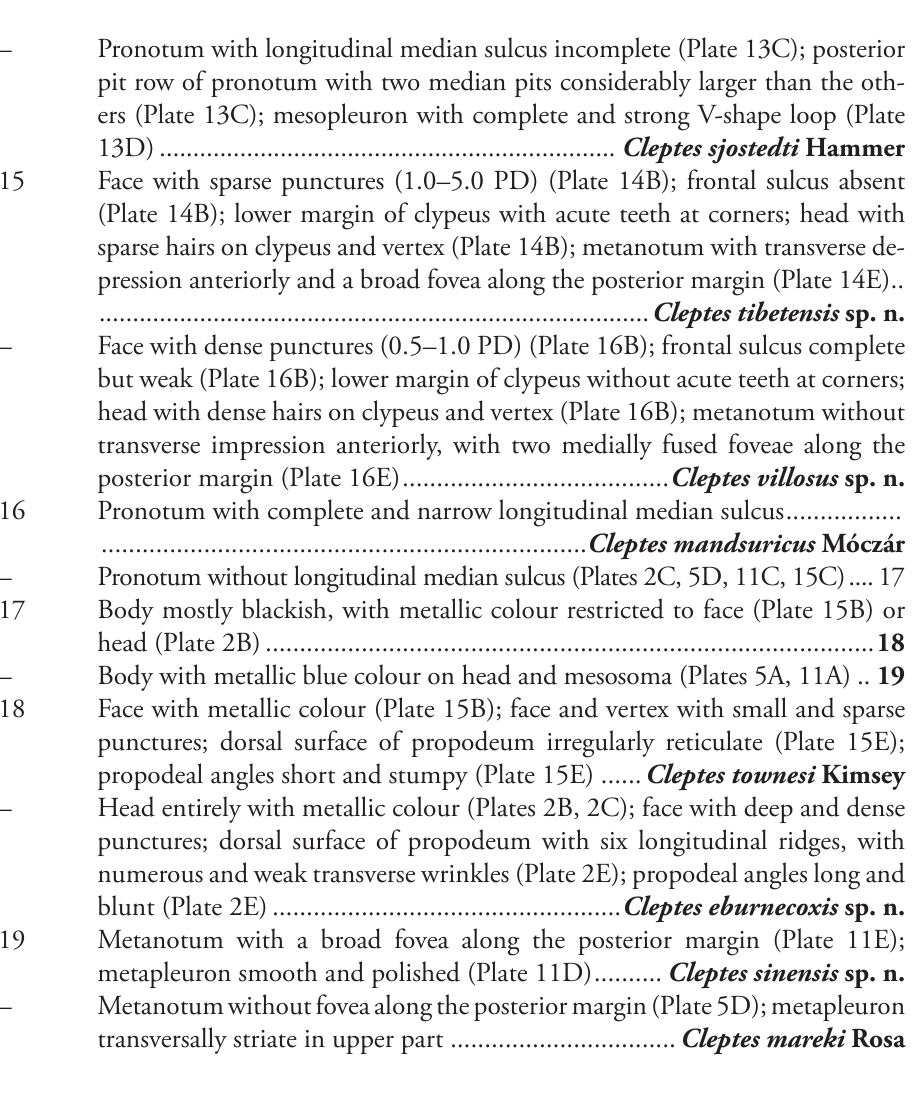
Cleptes asianus Kimsey, 1987 http://species-id.net/wiki/Cleptes_asianus Cleptes asianus Kimsey, 1987: 56; Kimsey and Bohart 1991: 59; Móczár 2000a: 325. Material examined. None. Diagnosis. Body entirely purple, including femora and tibiae. Flagellum dark brown to black. Tegulae and tarsi brown. Lower margin of clypeus truncate. Dorsal surface of propodeum coarsely punctuate, with propodeal angles obtuse (Kimsey 1987; Móczár